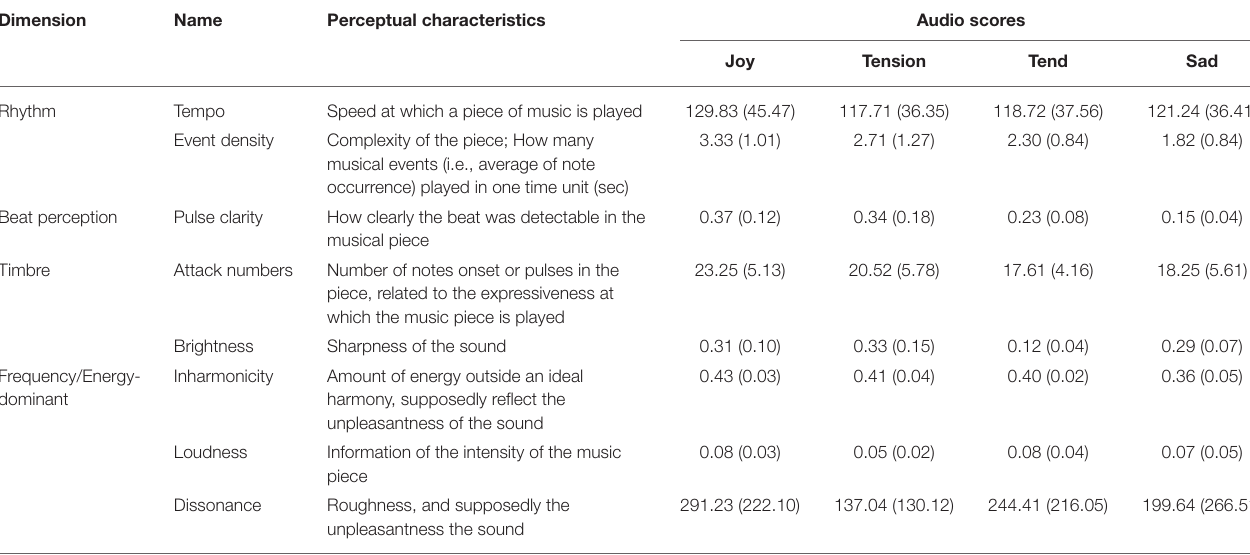
TABLE 2 | Acoustic characteristics of the music excerpts included in the study for the four emotion categories.